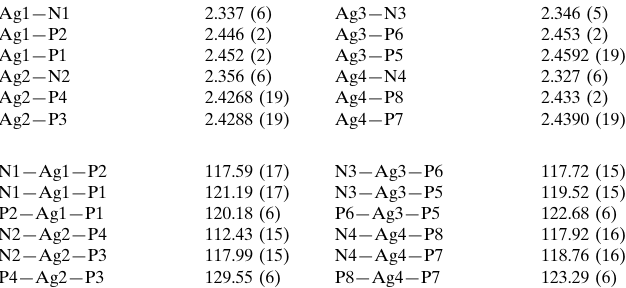
Selected geometric parameters (A˚ , (cid:2) ).